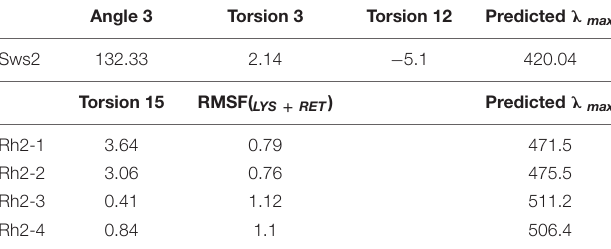
TABLE 2 | Area under the RMSF( LYS + RET ) curve and median values of various angles used to predict λ max values for each of the four Atlantic salmon Rh2 photopigments and a single Sws2 visual photopigment using the statistical